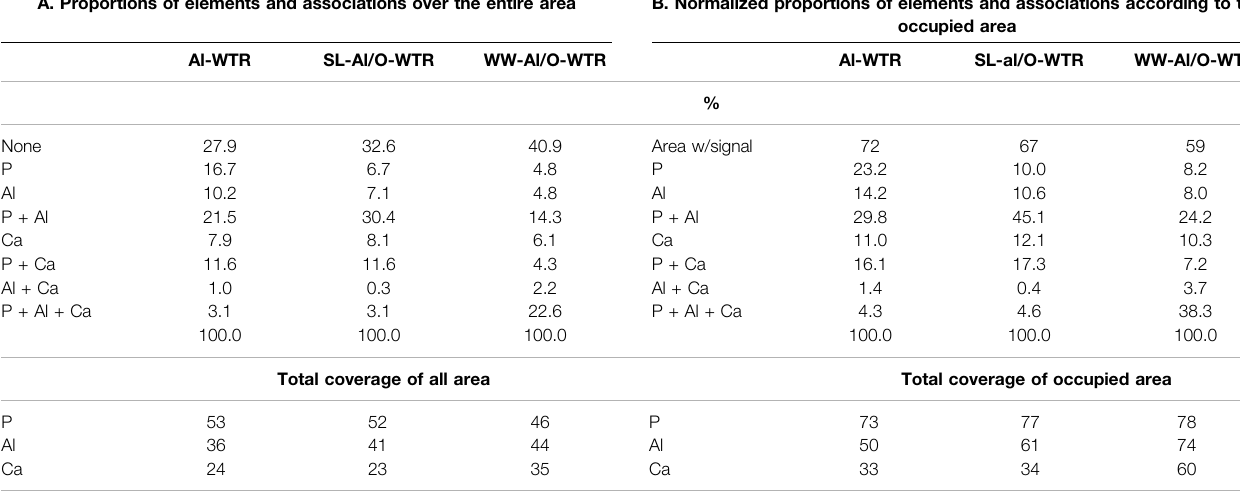
TABLE 3 | Elements and their associations, A. the results of the image analysis, B. the results normalized to the total occupied area. A. Proportions of elements and associations over the entire area B. Normalized proportions of elements and associations according to the